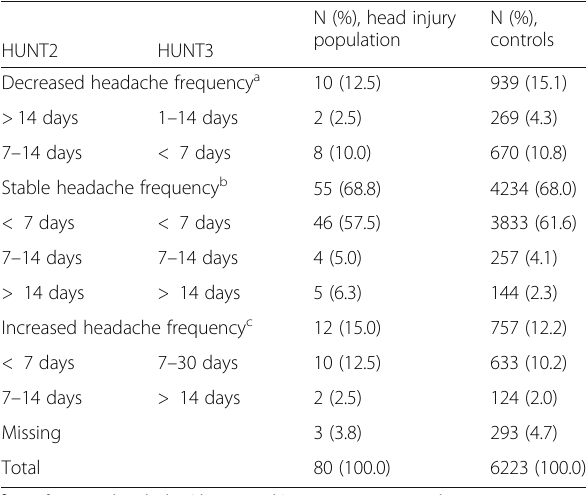
Table 3 Change in monthly headache frequency between HUNT2 and HUNT3 among participants suffering from headache in both surveys N (%), head injury